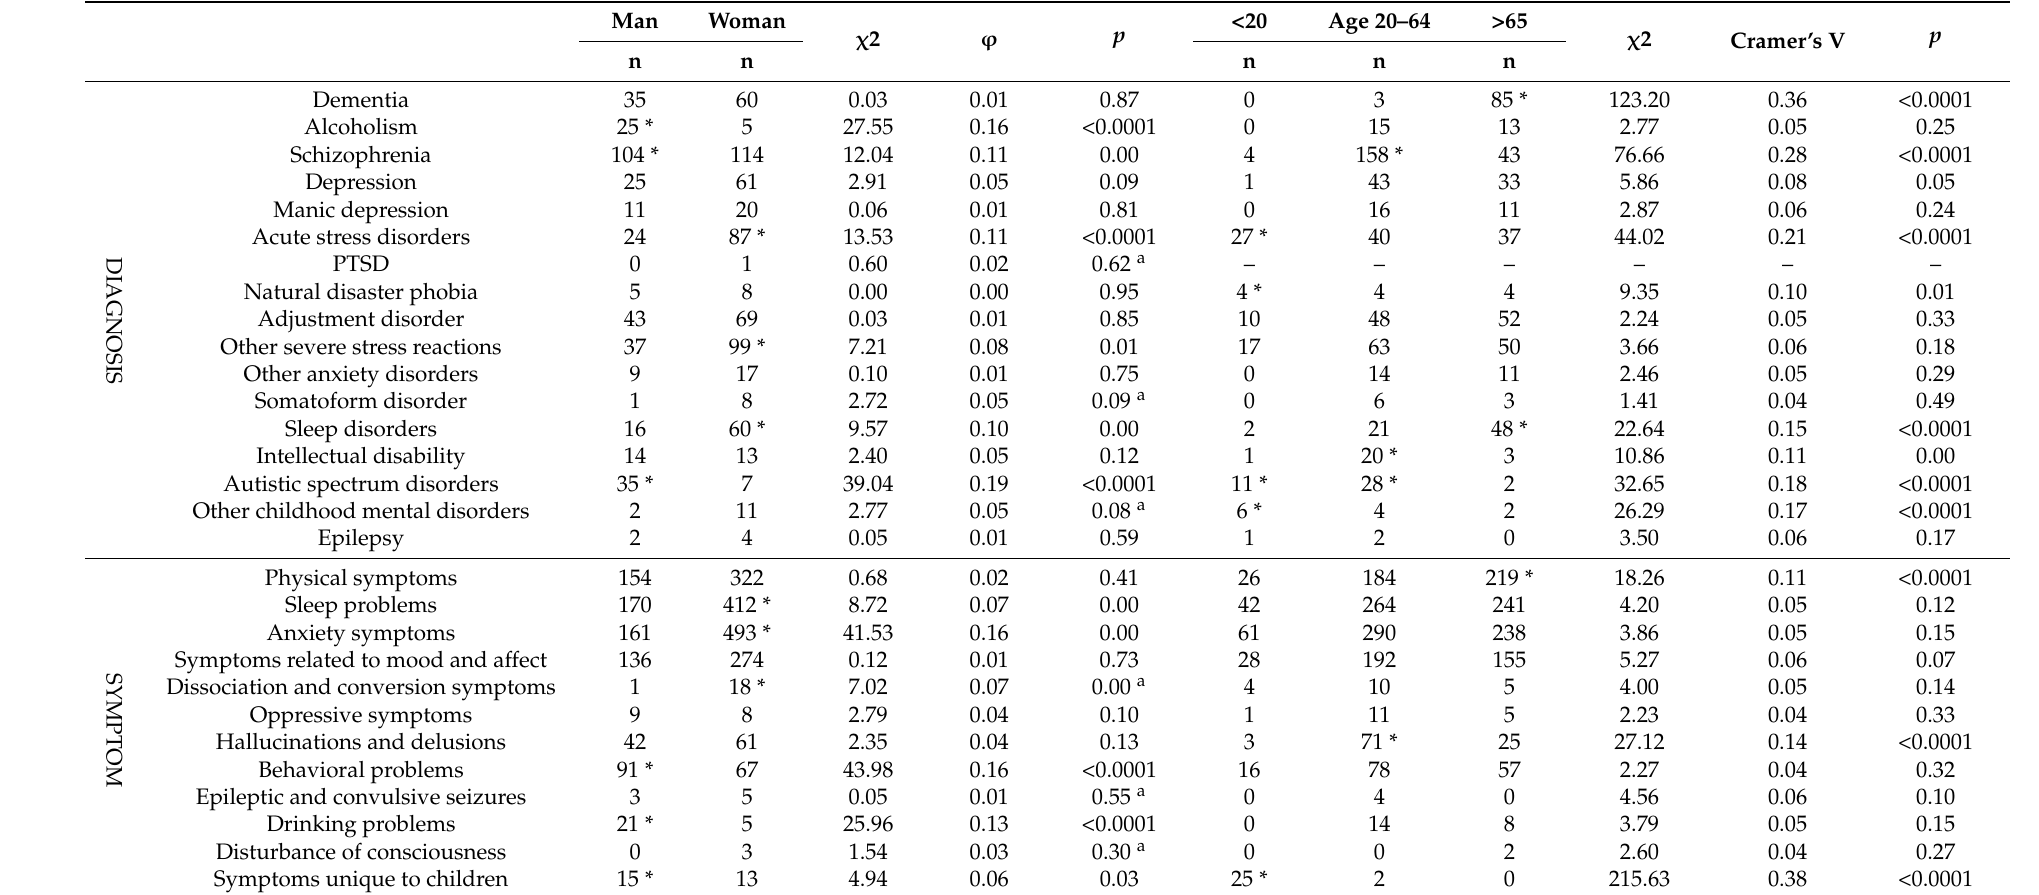
Table 2. Diagnosis and symptoms of Four Disasters: Comparison with the Subjects’ Basic